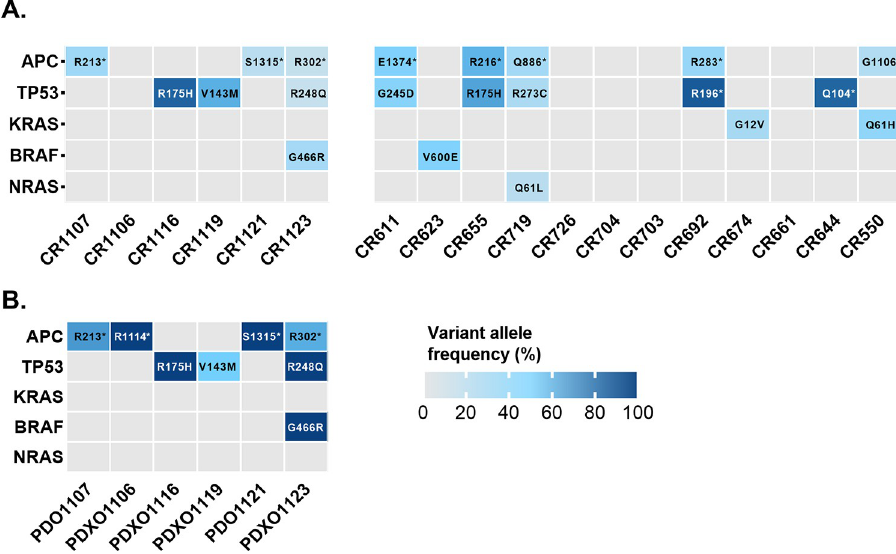
Fig 4. Variant allele frequencies of the pathogenic single nucleotide variants detected in CRCLM tumors ( A ) from 18 patients and in tumor organoids ( B ) derived from 6 of these patients. PDO; patient-derived tumor organoids, PDXO; patient-derived xenograft organoids. Amino acid change of each variant is displayed within the heatmap cells.